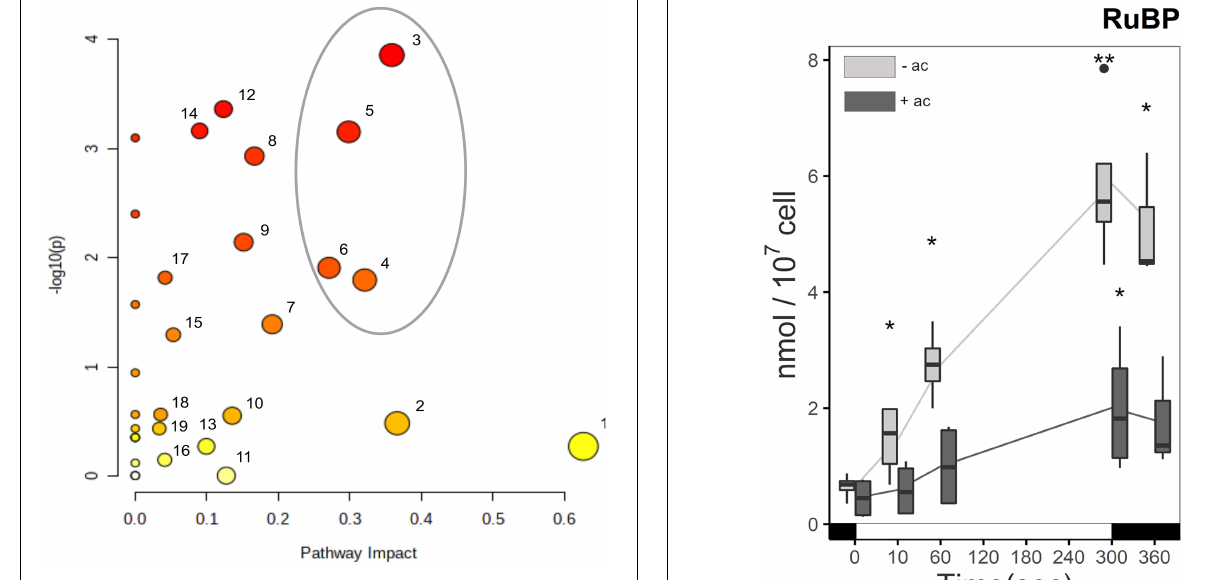
FIGURE 3 | Impact of acetate on metabolites accumulations and on cell metabolism. There are four replicates per metabolite per medium, samples have been taken after a 5 min light treatment (300 µ mol photons m − 2 s − 1 ). Metabolites were quantified per LC-MS/MS after quenching and extraction. Impact of accumulating metabolites on cell metabolism analyzed using MetaboAnalyst 5.0 (https://www.metaboanalyst.ca), sorted by the P -value; (1) alanine, aspartate, and glutamate metabolism, (2) pentose phosphate metabolism, (3) amino sugar and nucleotide sugar metabolism, (4) TCA cycle, (5) starch and sucrose metabolism, (6) glyoxylate and dicarboxylate metabolism, (7) carbon fixation, (8) pentoses and gluconarate interconversions, (9) nicotinate and nicotinamide metabolism, (10) purine metabolism, (11) arginine and proline metabolism, (12) galactose metabolism, (13) arginine biosynthesis, (14) glycerolipid metabolism, (15) glutathione metabolism, (16) glycine, serine, and threonine metabolism, (17) pyruvate metabolism, (18) sulfur metabolism, (19) fructose and mannose metabolism. The gray ellipse represents the most significantly affected pathways.